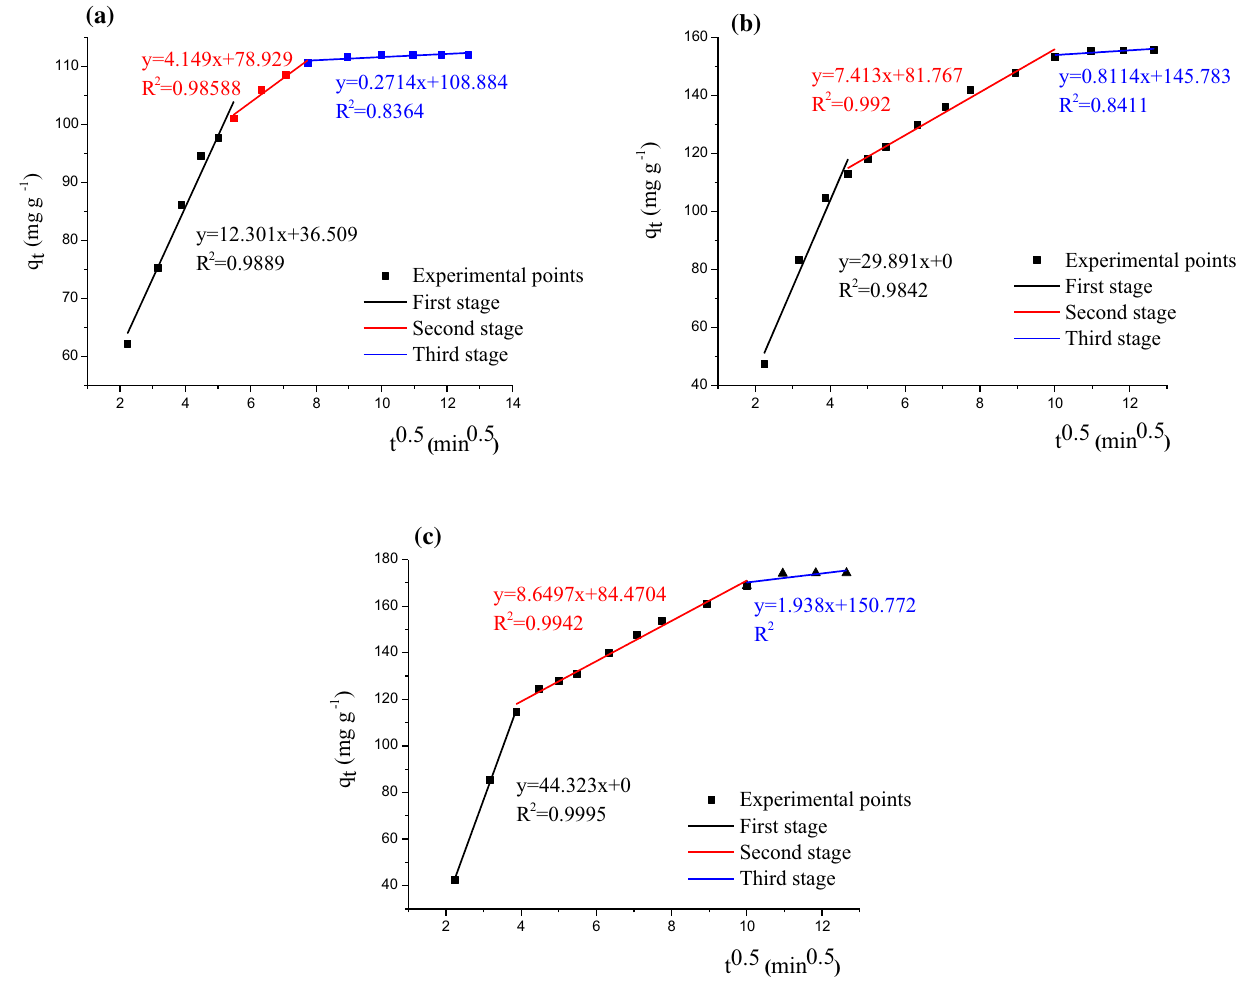
0.5 at different concentrations a 90 mg L −1 ; b 130 mg L −1 ; c 150 mg L −1 Fig. 8 Evolution of q e versus t